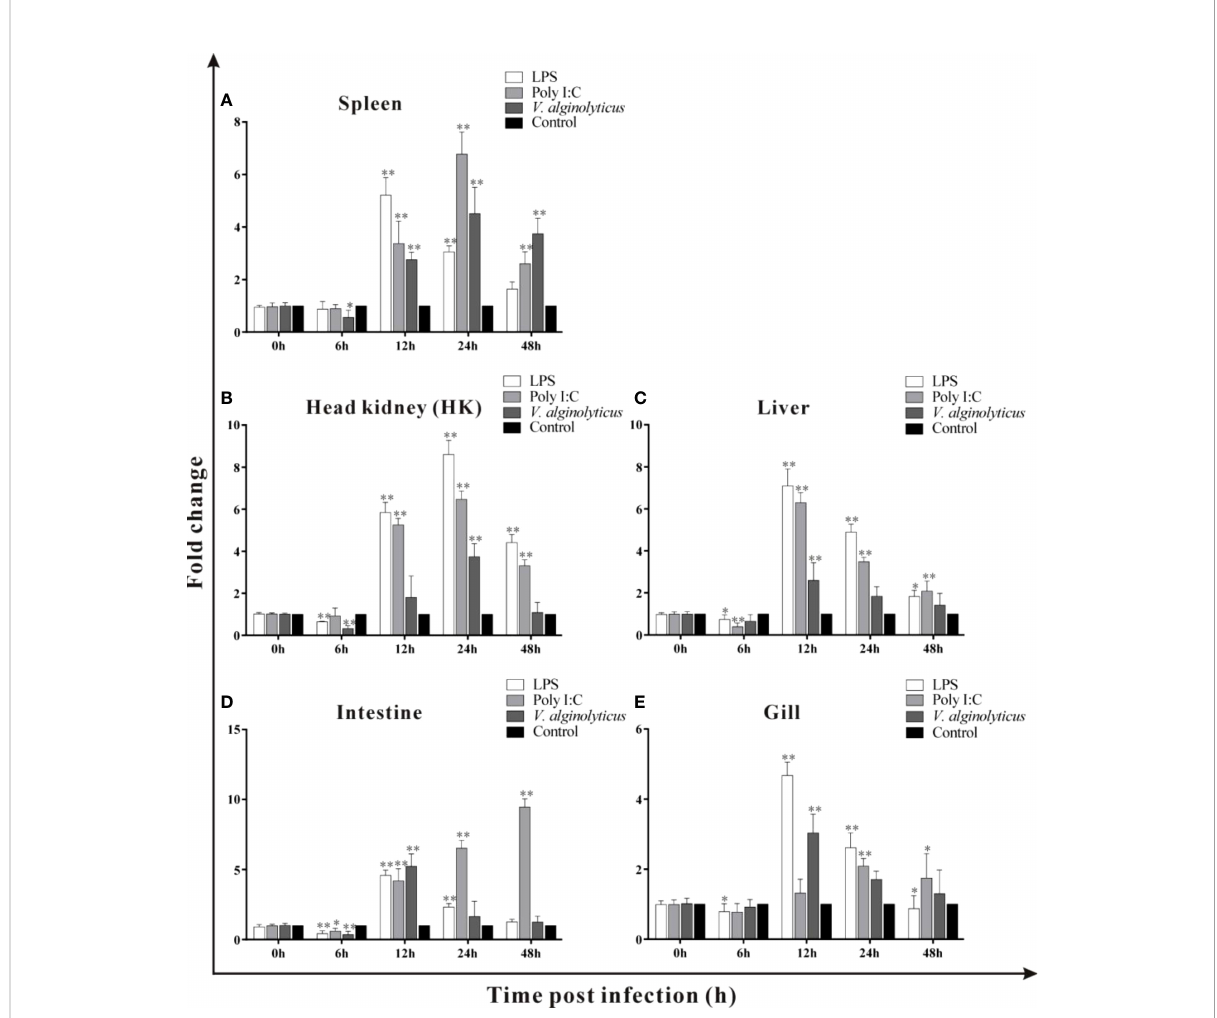
FIGURE 5 Expression patterns of trDIGIRR in spleen, head kidney (HK), liver, intestine and gill following the Vibrio alginolyticus , LPS and poly I:C challenge (A – E) . The relative expression of target gene in each tissue was normalized to that of b -actin. The expression changes of the two genes were analyzed using the 2 - △△ CT method and expressed as fold change. Results were means ± SE.* P <0.05, ** P